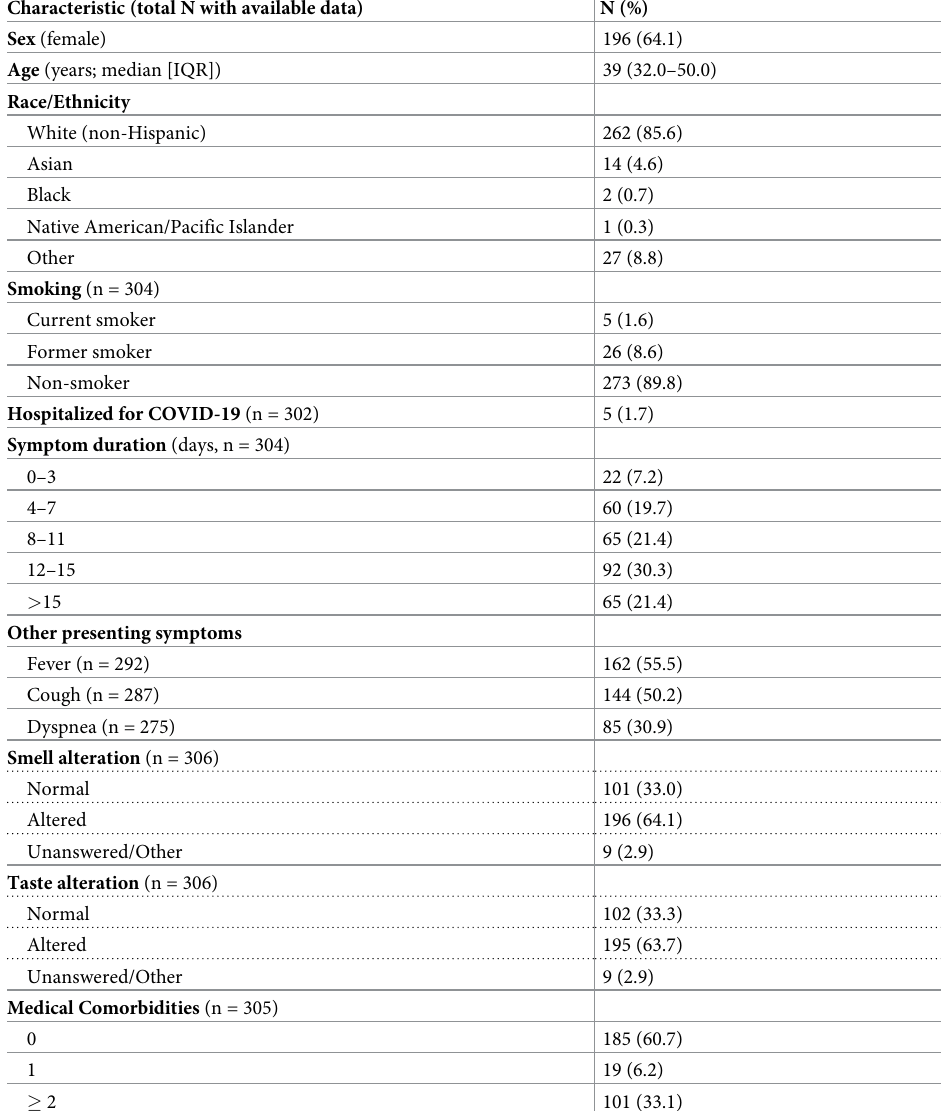
Table 1. Baseline characteristics of the study cohort (n = 306). Characteristic (total N with available data) N